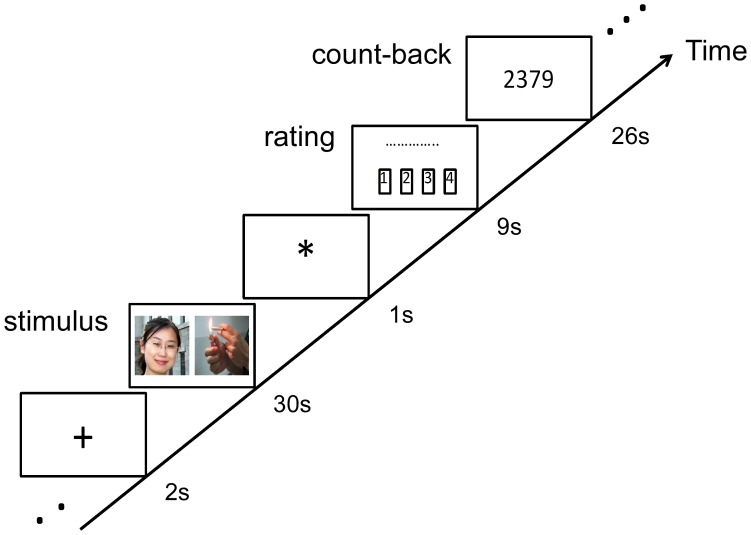
Sample block of experimental task and fMRI design.We used a 2 (partner vs. acquaintance) x2 (cigarette cue vs pen) factor design. Each of the four distinct blocks was repeated three times.